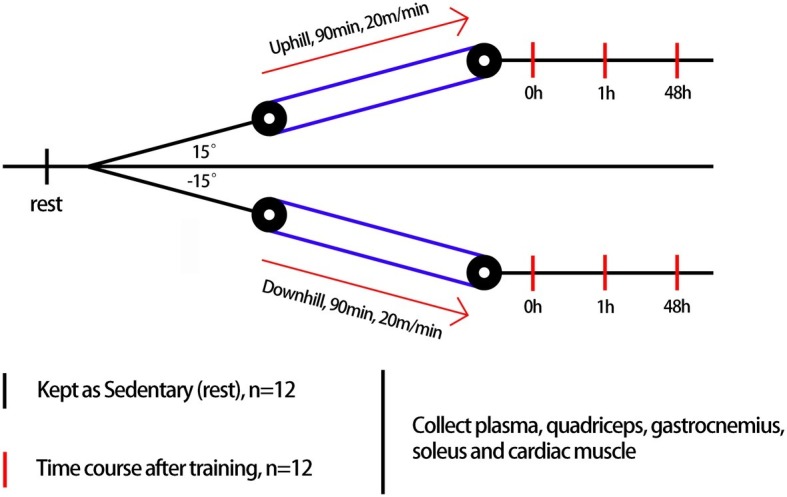
An overview of the experimental design.